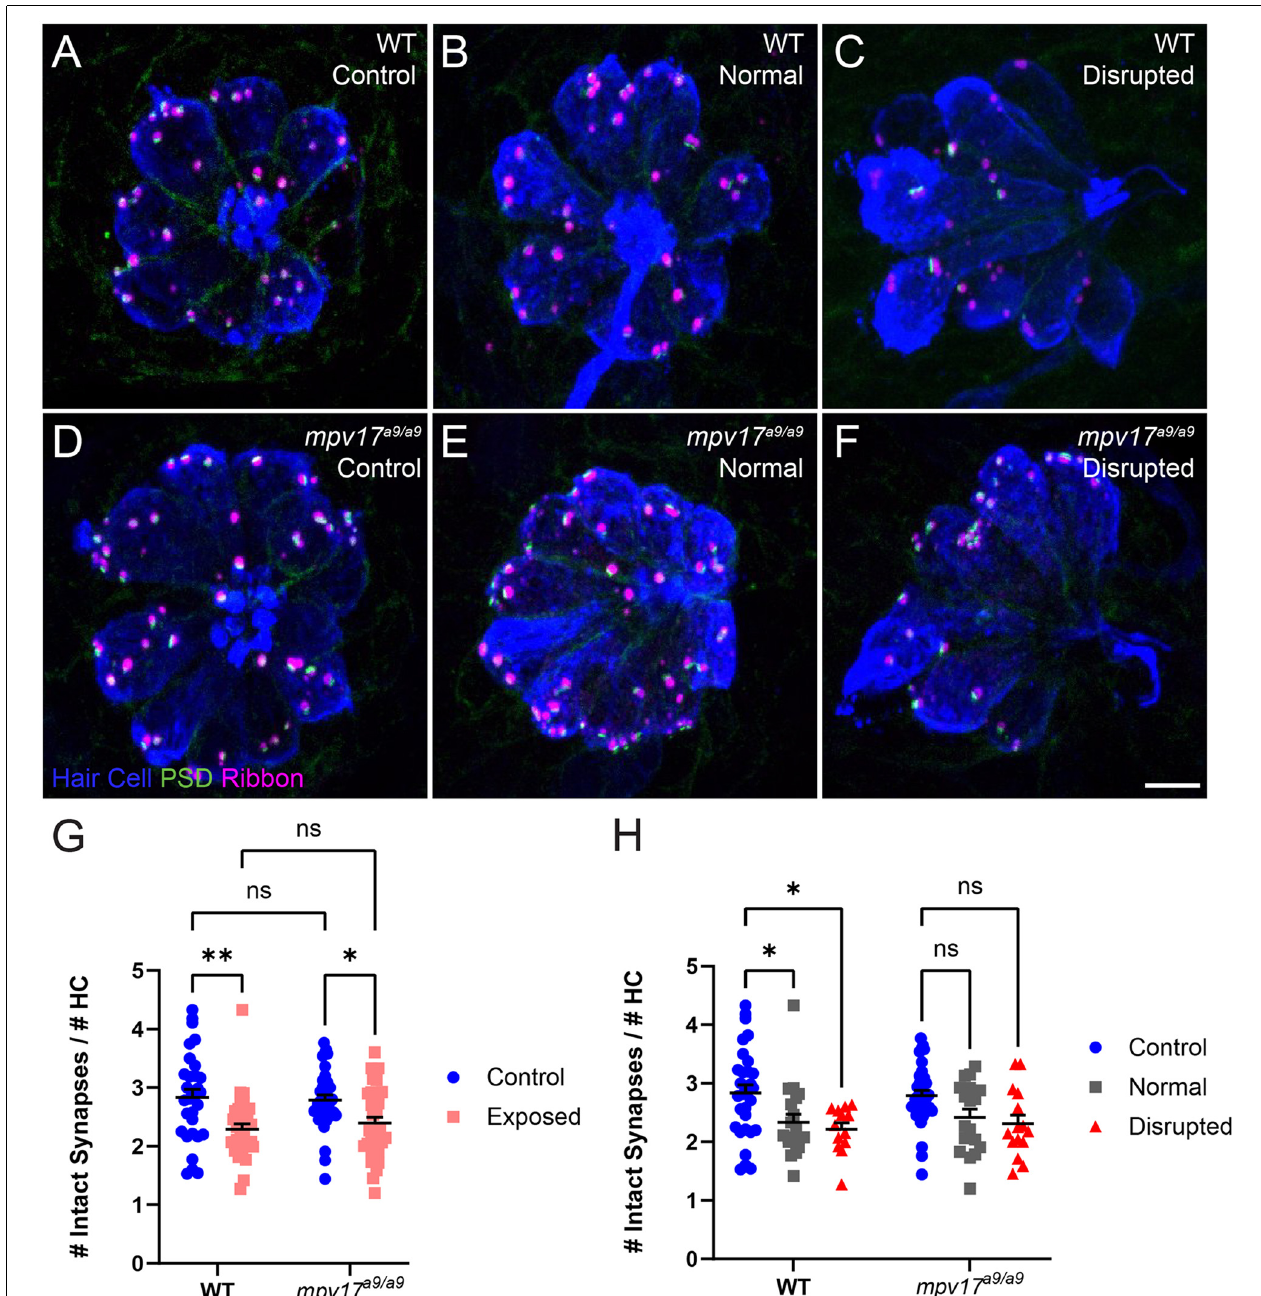
FIGURE 7 | Both WT and mpv17 a9/a9 neuromasts experience mechanically induced hair-cell synapse loss. (A–C) Maximum-intensity projections of confocal images showing neuromasts with Parvalbumin-labeled hair cells (blue), Ribeye b-labeled presynaptic ribbons (magenta), and MAGUK-labeled PSD (green). Unexposed control neuromasts are shown in ( A ; WT) and ( D ; mpv17 a9/a9 ); exposed neuromasts with normal morphology are shown in ( B ; WT) and ( E ; mpv17 a9/a9 ); and exposed neuromasts with disrupted morphology are shown in ( C ; WT) and ( F ; mpv17 a9/a9 ). (G,H) Quantification of average numbers of intact synapses per hair cell. Each data point refers to the average number of intact synapses per hair cell in one neuromast per fish. Synapse number is reduced in both WT and mpv17 a9/a9 neuromasts ( G ; ∗∗ P = 0.0020 WT; * P = 0.0313 mpv17 a9/a9 ). This reduction was consistent in both normal and disrupted neuromasts ( H ; ∗ P = 0.0483 WT normal; ∗ P = 0.0272 WT disrupted). n = 13–36 fish (neuromasts L3, L4, and L5); N = 7 experimental trials. Scale bar: 5 µ m. Error bars: SEM. “ns” = not significant. PSD, postsynaptic density.